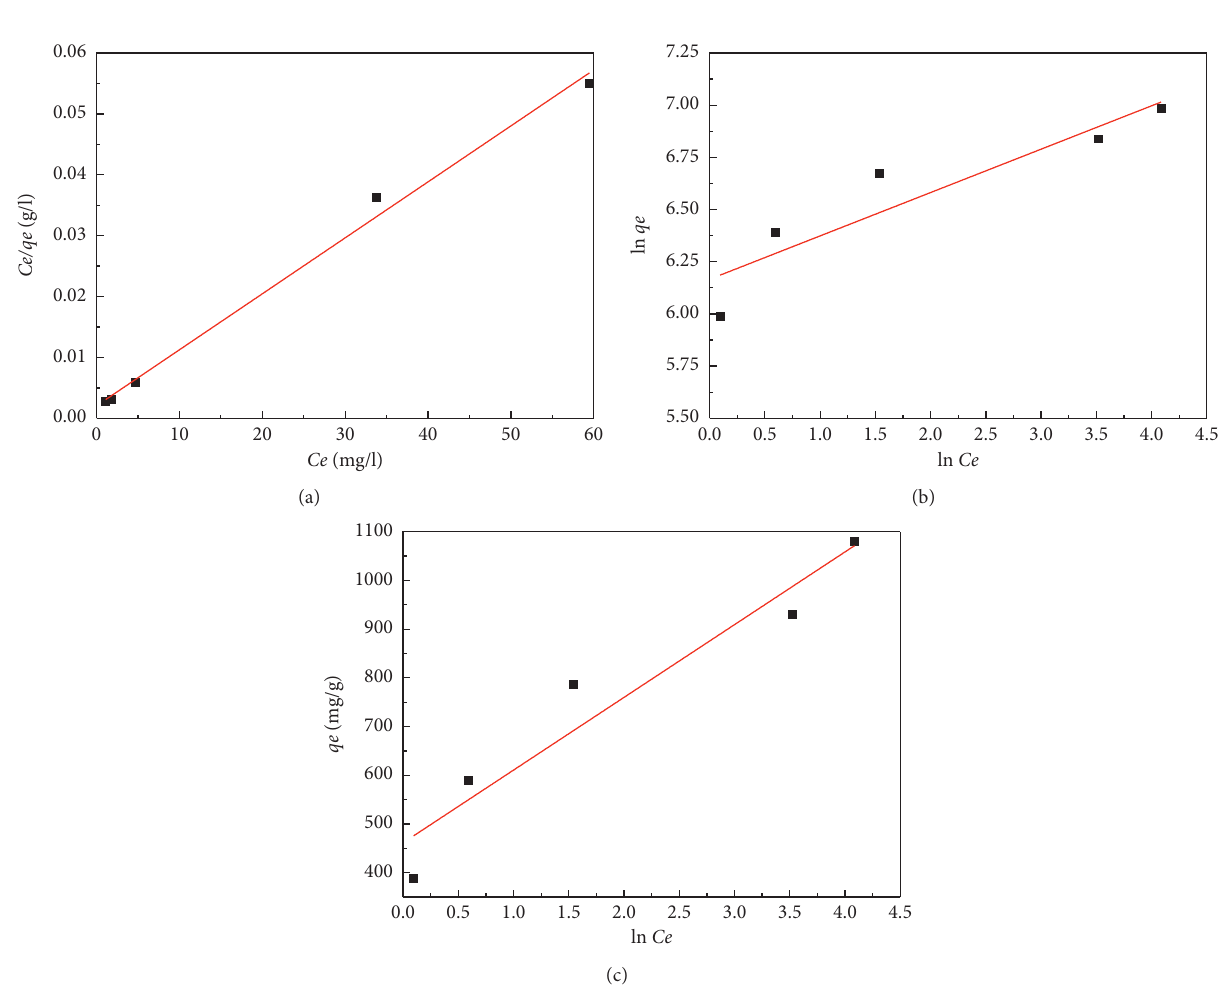
Figure 7: (a) Langmuir, (b) Freundlich, and (c) Temkin adsorption isotherms of PPAC.